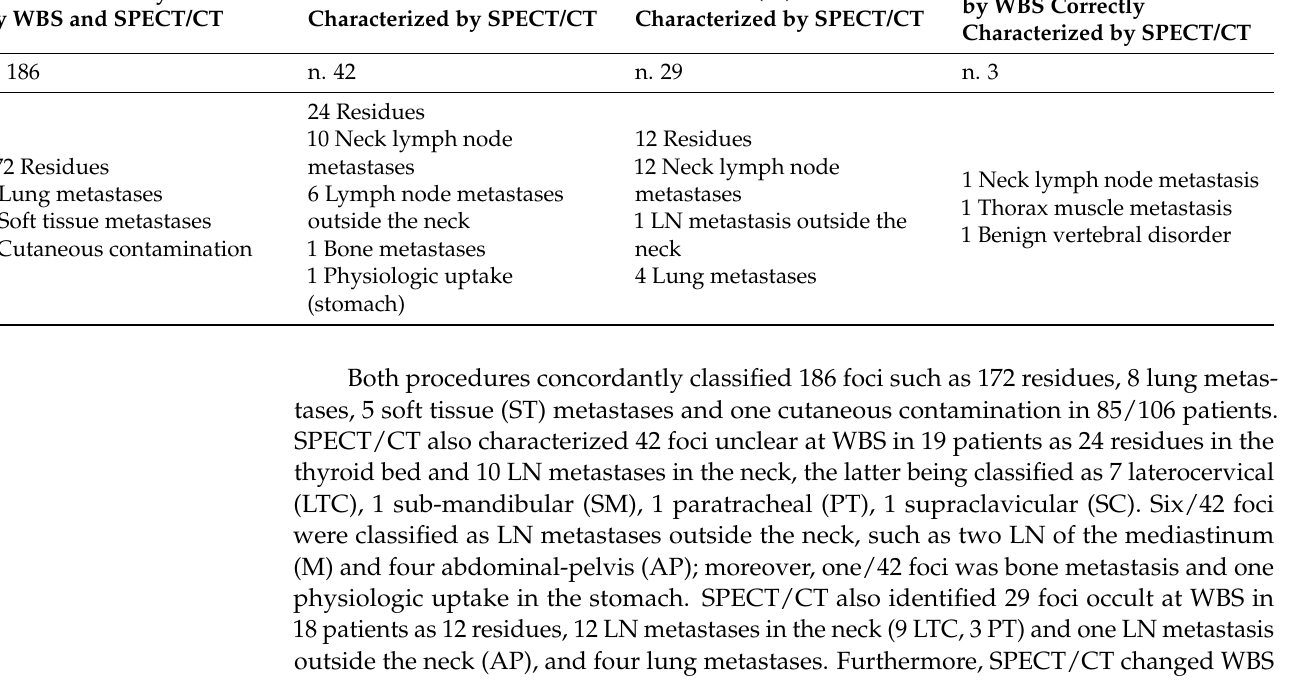
Table 2. Radioiodine-avid foci evidenced and characterized by SPECT/CT (n. 260) and by WBS (n. 231) during ablation. Foci Concordantly Classified by WBS and